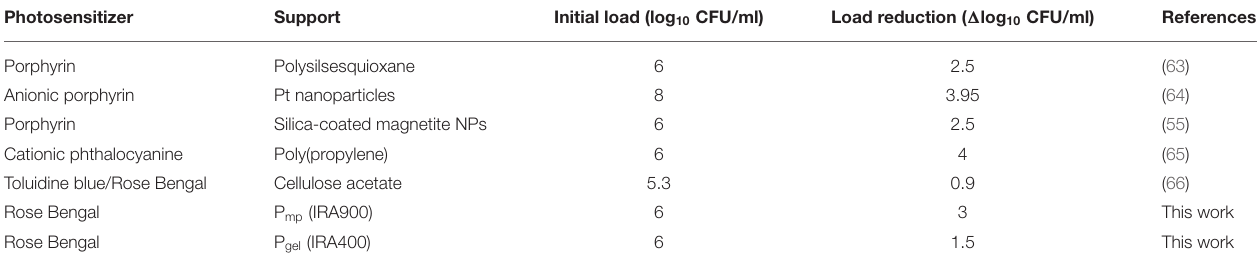
TABLE 4 | Representative examples reported in literature of Candida albicans inactivation caused by photosensitizing materials.